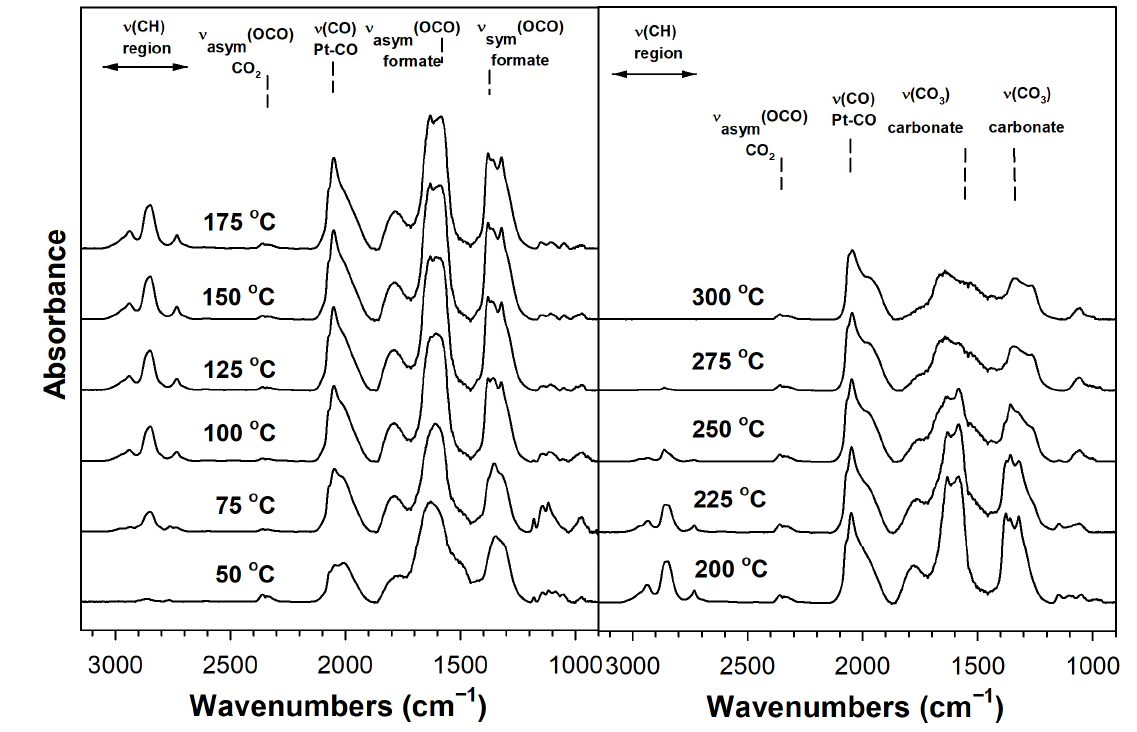
Figure 3. DRIFTS of steam reforming of formaldehyde over 0.5%Na-2%Pt/m-ZrO 2 .